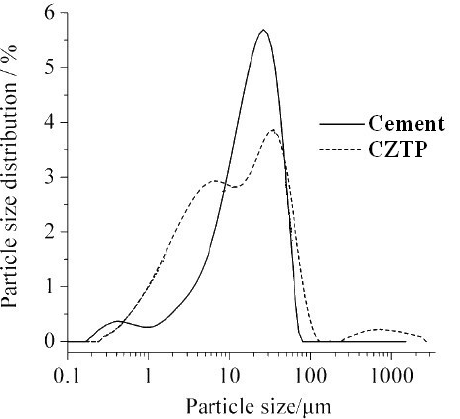
Figure 3. Particle size distribution of Portland cement and copper-zinc tailing powder. The formulations to produce composite binder pastes and mortars are shown in Tables 2 and 3, respectively. A water-to-binder (w/b) ratio of 0.45 was used, and the substitution ratios of CZTP were 0, 10%, 20%, 30%, and 50% by mass, with additions of 7.6 g superplasticizer. The samples given in Table 2 and Table 3 were identified using the selected parameters of w/b and CZTP content. For example, specimen 3_20b indicates a paste produced with 20 wt.% CTZP at w/b of 0.30. Specimen 3_20m indicates a mortar produced with 20 wt.% CZTP at w/b of 0.30. The specimens were demolded after 24 h and then maintained at 20 ± 1 °C and >90% RH. Table 2. Mix proportions of composite binder pastes.